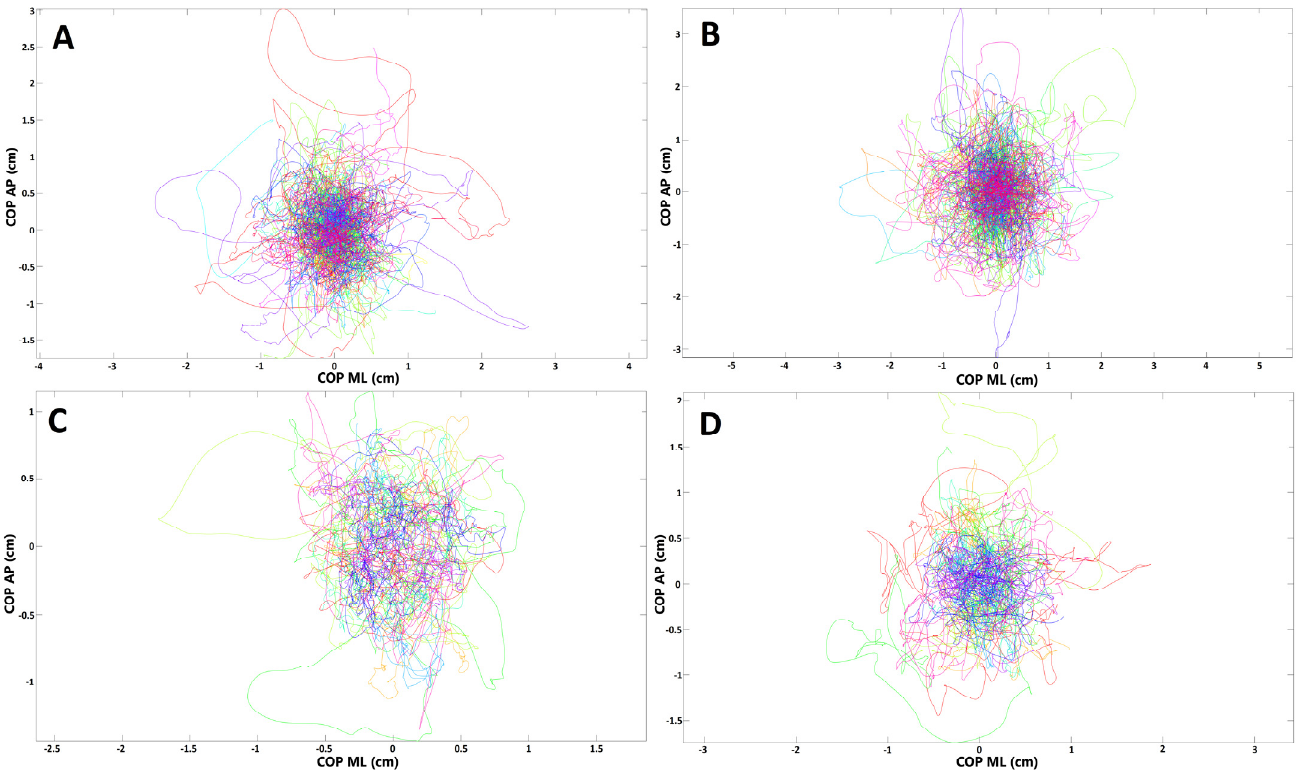
Figure 2. Presentation of COP (center of pressure) migrations in ( A , B ) subjects who had olfactory abnormalities during COVID–19; ( C , D ) subjects without such ailments (each line represents single participant; AP, anterior–posterior (frontal) plane; ML, medial–lateral (sagittal) plane). ( A , C ) Trials with eyes open; ( B , D ) trials with eyes closed.